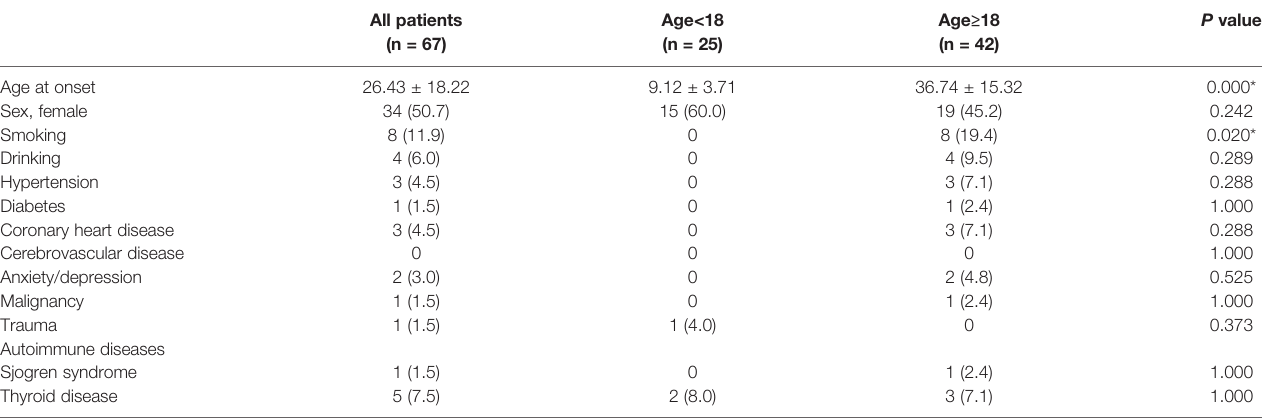
TABLE 1 | Patient demographics and comorbidities.